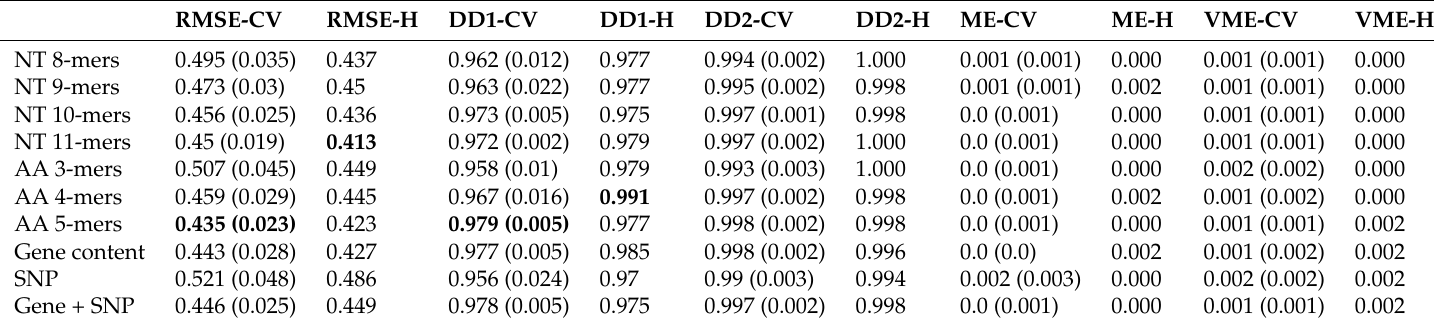
Table A56. S. enterica